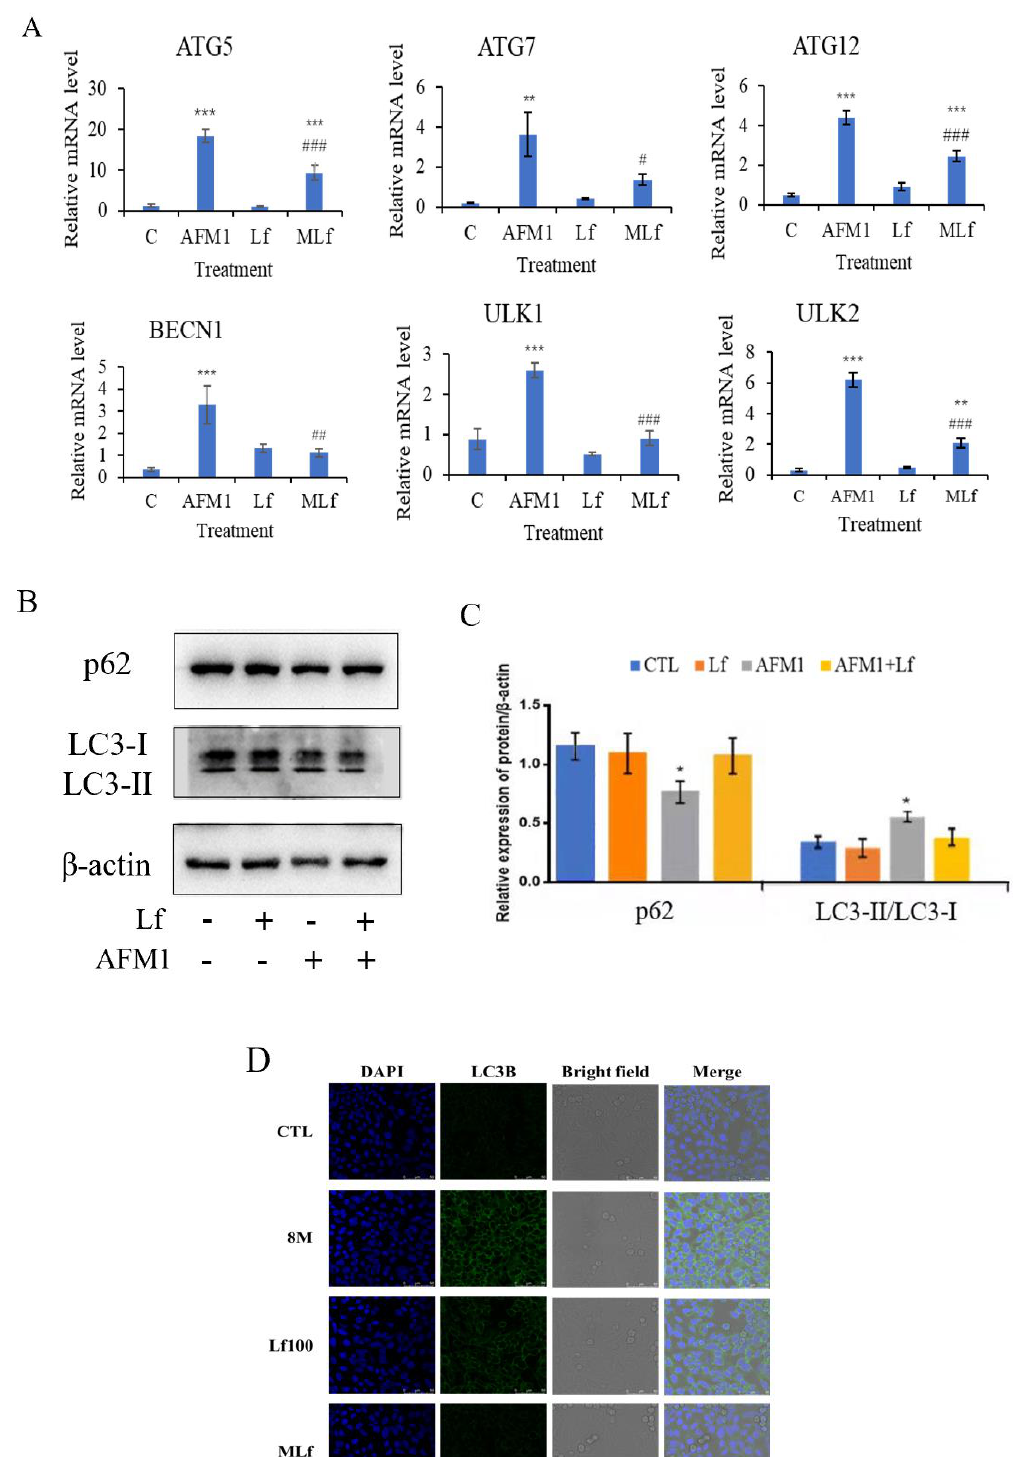
Figure 3. Lf alleviates AFM1-induced autophagy in NCM460 cells. 100 µ g/mL Lf and 8 µ g/mL AFM1 were treated in NCM460 cells alone or in combination. ( A ) Relative mRNA levels of autophagy genes. ( B , C ) Immunoblotting was performed on protein extracts for autophagy proteins and band densities quantification. ( D )The changes of LC3 positive level were analyzed by confocal microscope. Results represented as means ± SD. * p < 0.05, ** p < 0.01, *** p < 0.001 vs. control (C/CTL). # p < 0.05, ## p < 0.01, ### p < 0.001 vs.